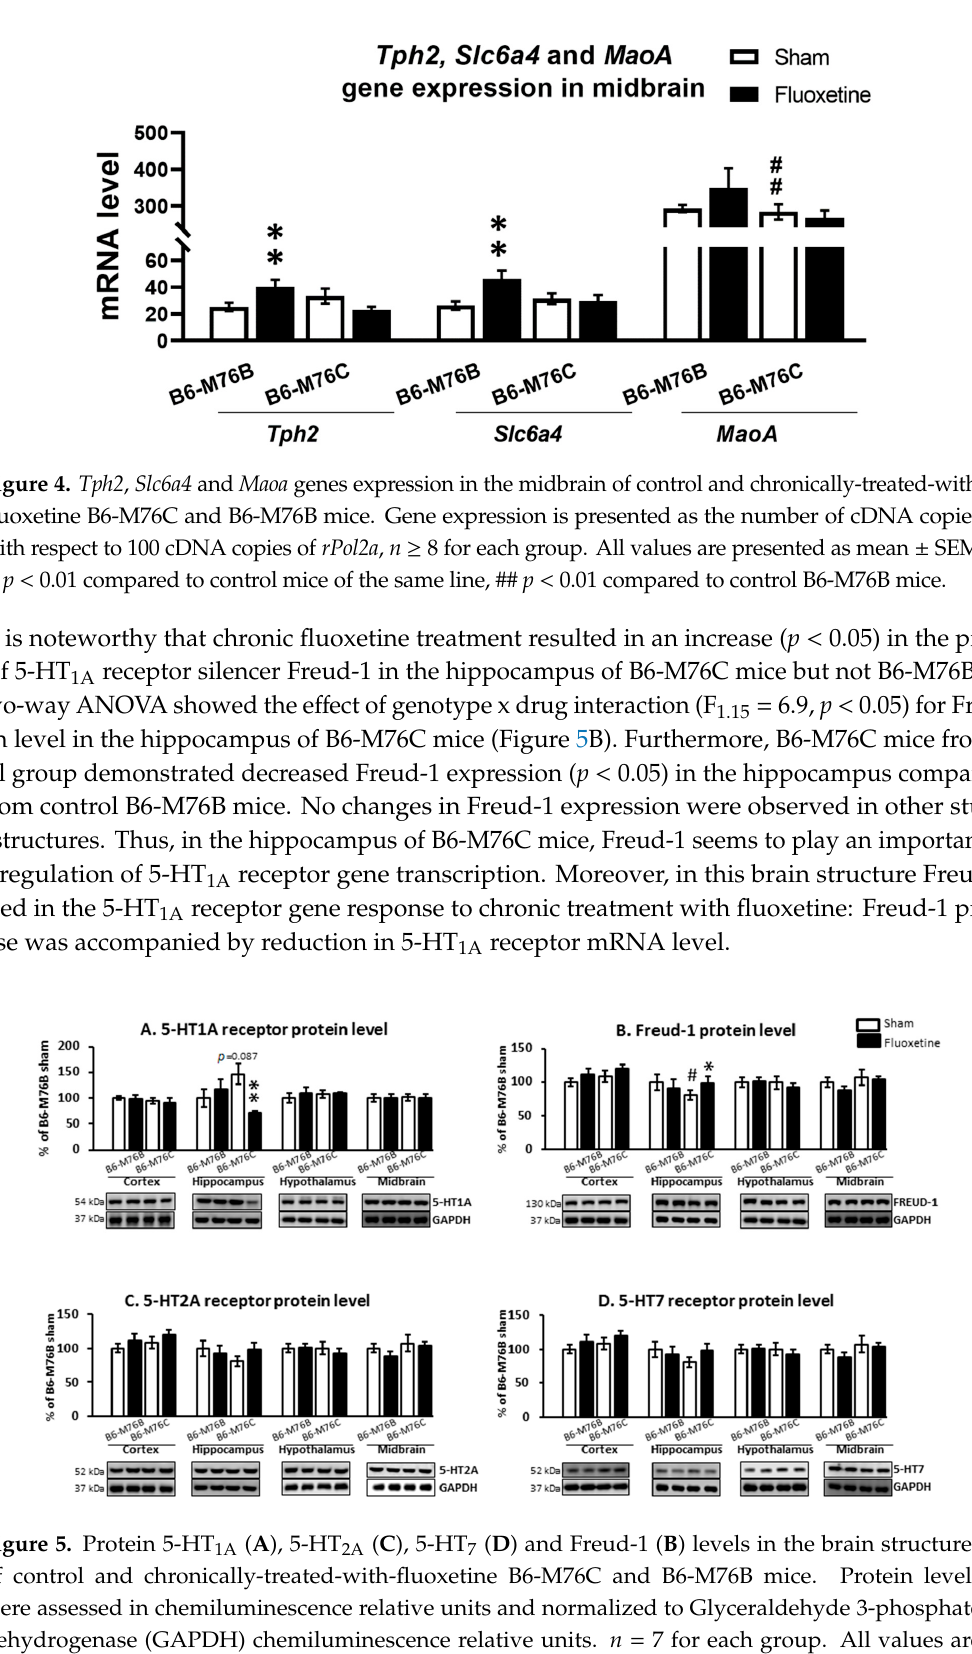
Figure 5. Protein 5-HT 1A ( A ), 5-HT 2A ( C ), 5-HT 7 ( D ) and Freud-1 ( B ) levels in the brain structures